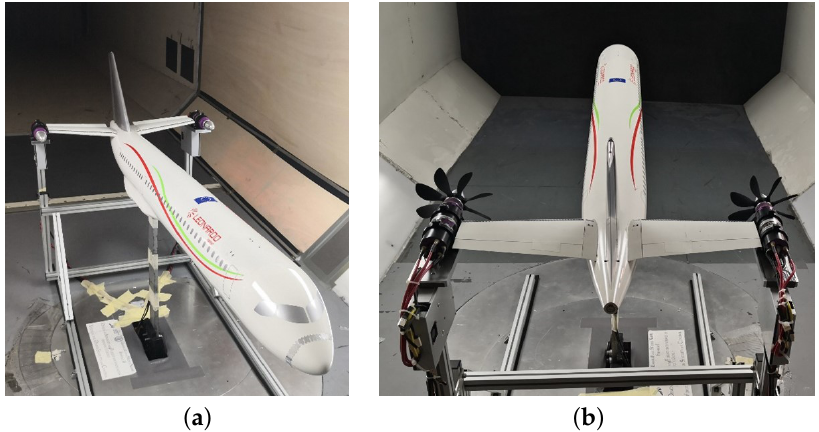
Figure 10. Body-Horizontal-Vertical tail configuration tested in wind tunnel: ( a ) power-off BHV configuration; ( b ) power-on BHV